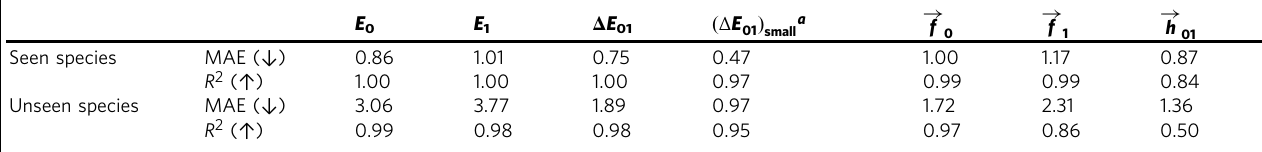
Table 1 MAE and coef fi cient of determination ( R 2 ) of the DANN model for various